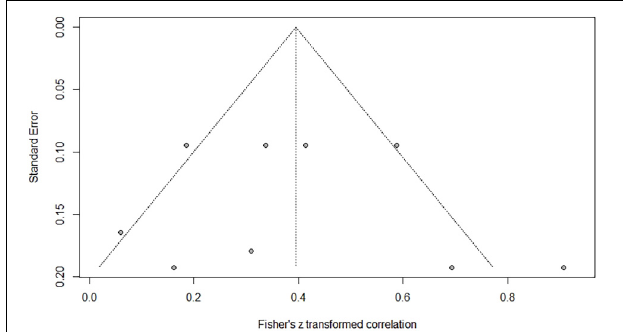
FIGURE 9 | Adjusted funnel plot of effect sizes vs. standard error for rapid automatized naming and Chinese word reading.